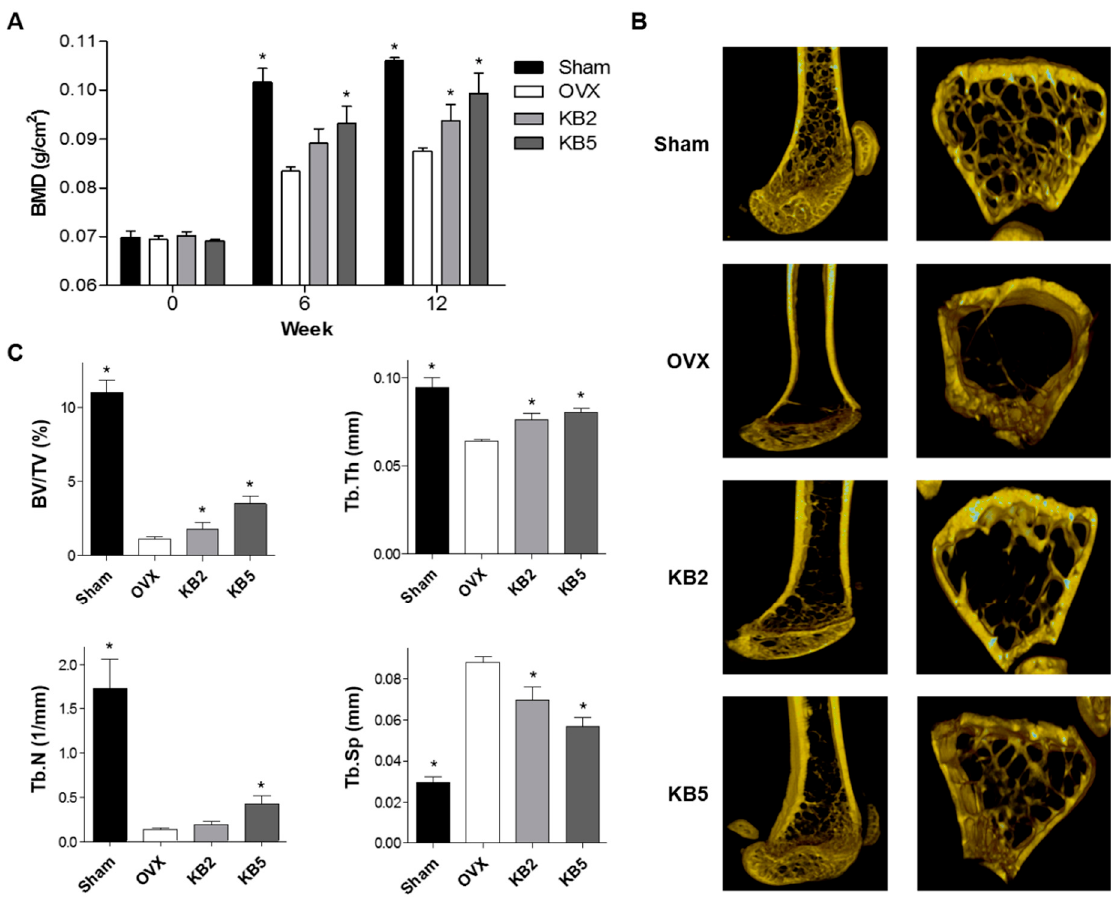
Figure 6. The effects of kukoamine B (KB) on the improvement of bone mineral density (BMD) and bone structural properties in ovariectomized (OVX) osteoporosis model mice. The OVX mice were administered with KB (2 or 5 mg / kg / day) for 12 weeks. Sham: Sham-operated group ( n = 5), OVX: KB non-administered mice group ( n = 5). ( A ) BMD of the right femur was measured using a PIXI-mus bone densitometer at 0, 6, and 12 weeks. ( B ) Transverse microcomputed tomography (micro-CT) images of the right femur were scanned at the end of the experiment. ( C ) Trabecular bone structural properties, including bone volume (BV / TV), trabecular thickness (Tb.Th), number (Tb.N), and spacing (Tb.Sp), were analyzed at the end of the experiment. *: p < 0.05 vs. OVX group.